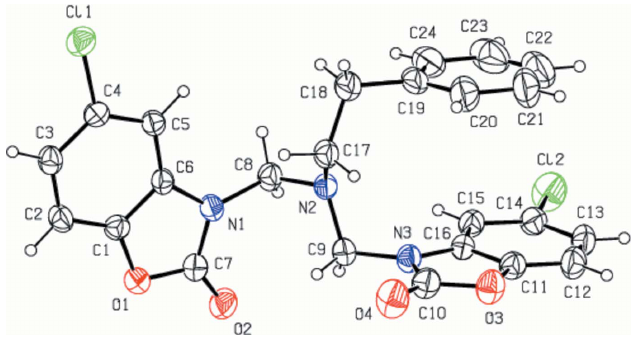
Figure 1 View of the title molecule with the atom-numbering scheme. Displace- ment ellipsoids for non-H atoms are drawn at the 30% probability level.